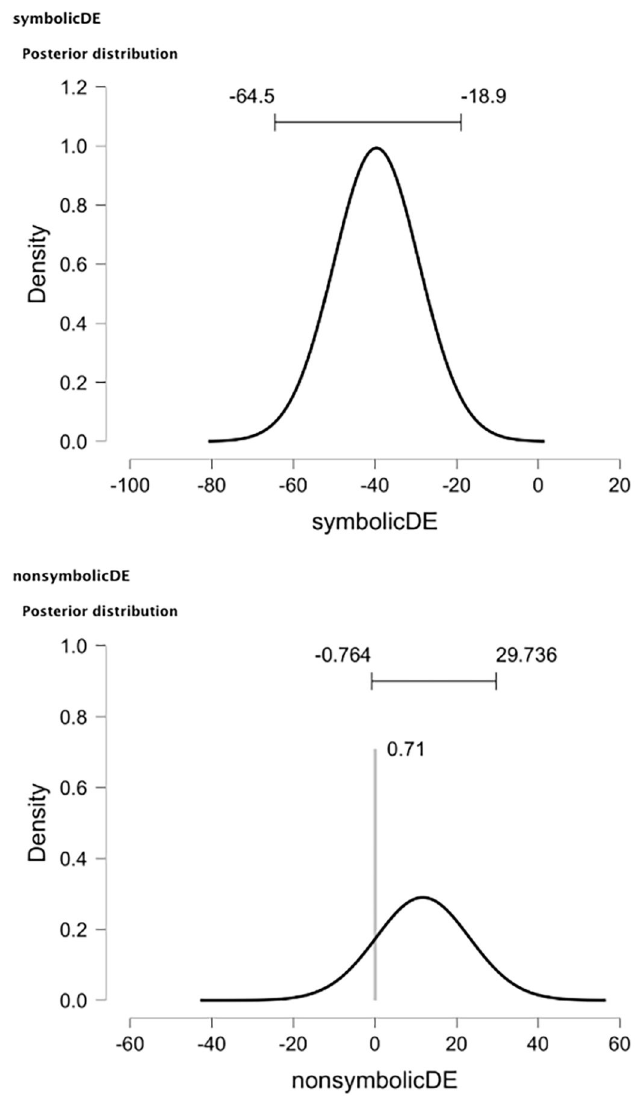
Figure 9. JASP screenshot showing the marginal posterior distribution for the symbolicDE ( β predictors in our linear regression example. The “spike” at zero with 0.71 represents the posterior model probability that the nonsymbolic coefficient β is 2